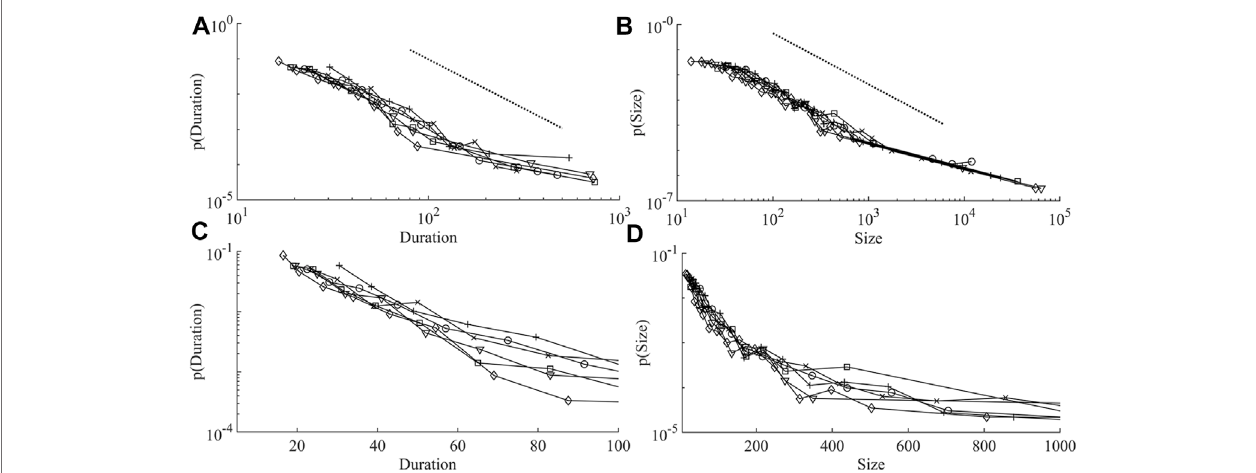
FIGURE2| Durationandsizedistributionsinallnetworks. (A) showsthedurationdistributions,thedashedlineisaperfectpower-lawwithexponent2.8. (B) shows thesizedistributions,thedashed lineisaperfect power-law withexponent 2.06. (C,D) aresemilog(logy,linearx)plotsoftheinitialparts ofboth distributions.Network1 (o), network 2 (x), network 3 (+), network 4 ( □ ), network 5 ( ▽ ), and network 6 ( ◇ ).